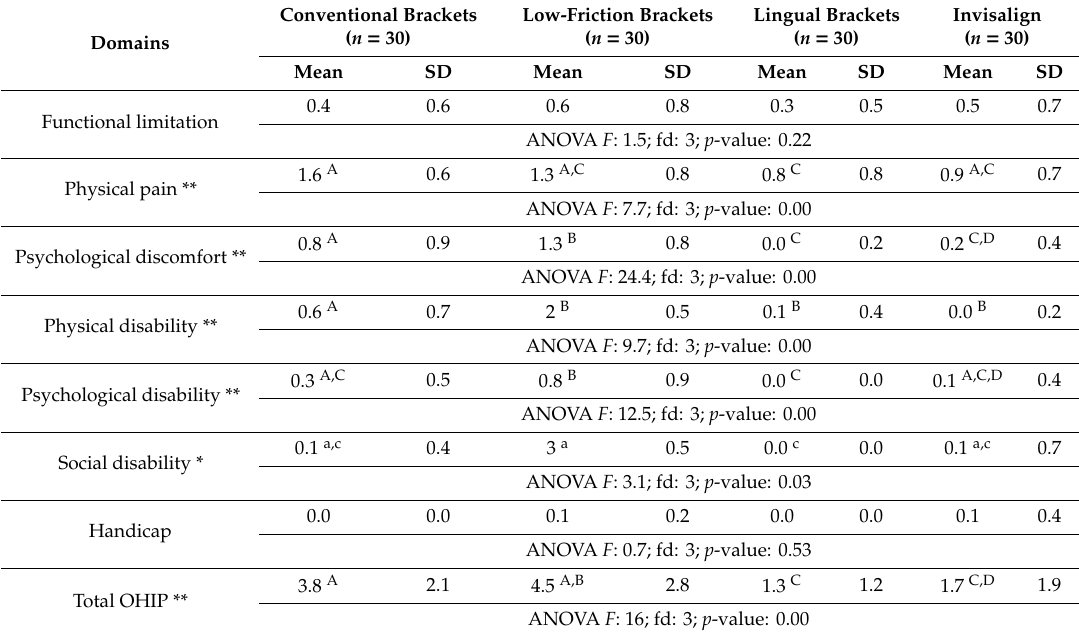
Table 3. Comparison of the impact on the quality-of-life domains among the treatment groups ( n = 120). Conventional Brackets Low-Friction Brackets Lingual Brackets Invisalign ( n = 30) ( n = 30) ( n = 30) ( n = 30) Domains Mean SD Mean SD Mean SD Mean SD 0.4 0.6 0.6 0.8 0.3 Functional limitation